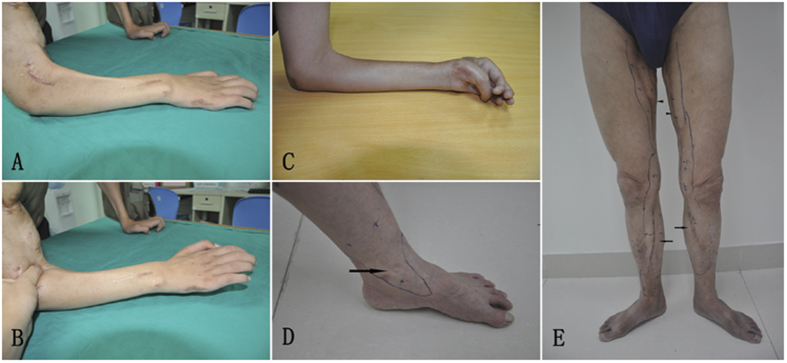
Long-term complications: (A) Showed the bowstrings complication. (B) The wrist and fingers extension improved after compress the “pulley site”. (C) This patient suffered severe stiffness of the elbow, wrist and fingers which lead to barely joints movement. (D) Showed the mild edema of ankle joint (arrow). (E) Showed the patient suffered hypoesthesia at the donor site; arrow head showed the hypoesthesia zone after gracilis dissection, arrow showed the hypoesthesia zone after initial sural nerve dissection.